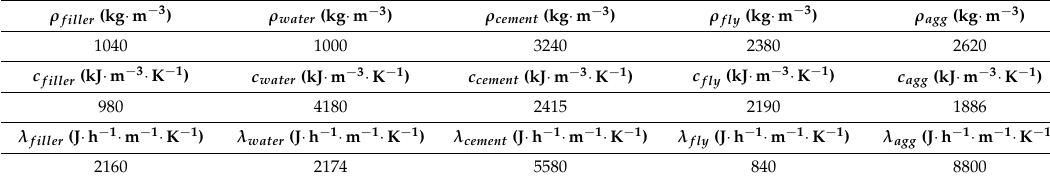
Table 2. Thermal parameters of the components.